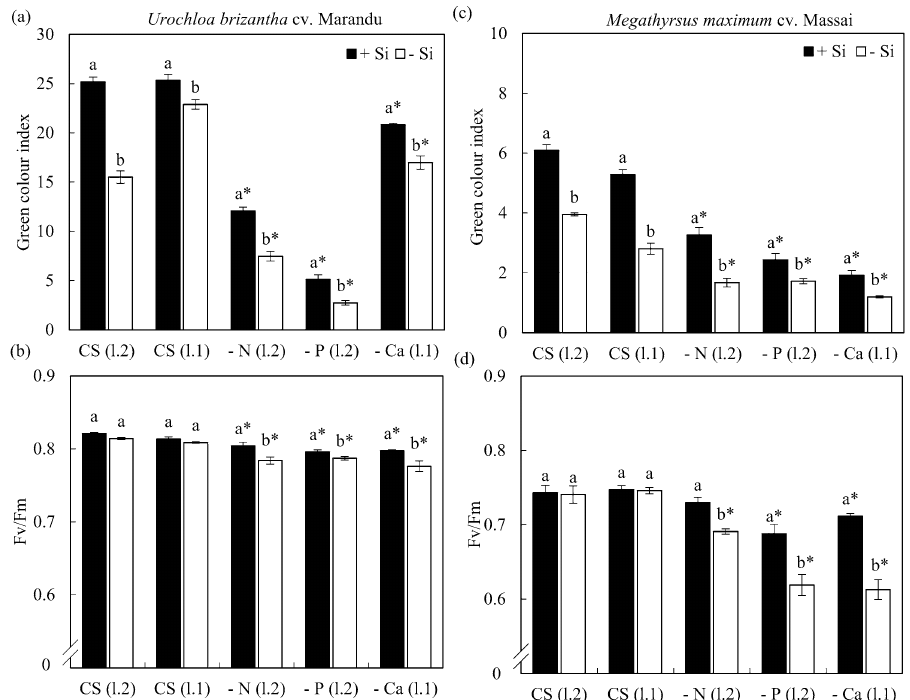
Figure 3. Green colour index ( a , d ) and Fv/Fm ( b , d ) of Urochloa brizantha cv. Marandu and Megathyrsus maximum cv. Massai under grown in complete solution (CS) and deficiency of nitrogen (−N), phosphorus (−P) and calcium (−Ca), combined with Si (+Si) and without Si (−Si). Different letters indicate a significant difference between treatments in the +Si and −Si condition. *Indicates a significant difference between treatments with nutritional deficiencies in relation to treatments with CS. The treatments of CS (l.2) are compared with the treatments −N (l.2), −P (l.2), refer to values obtained by the evaluation of the second fully expanded sheet. The treatments of CS (l.1) are compared with the values of −Ca (l.1) and refer to the first leaf. The comparison of means was performed using the Tukey test ( p <